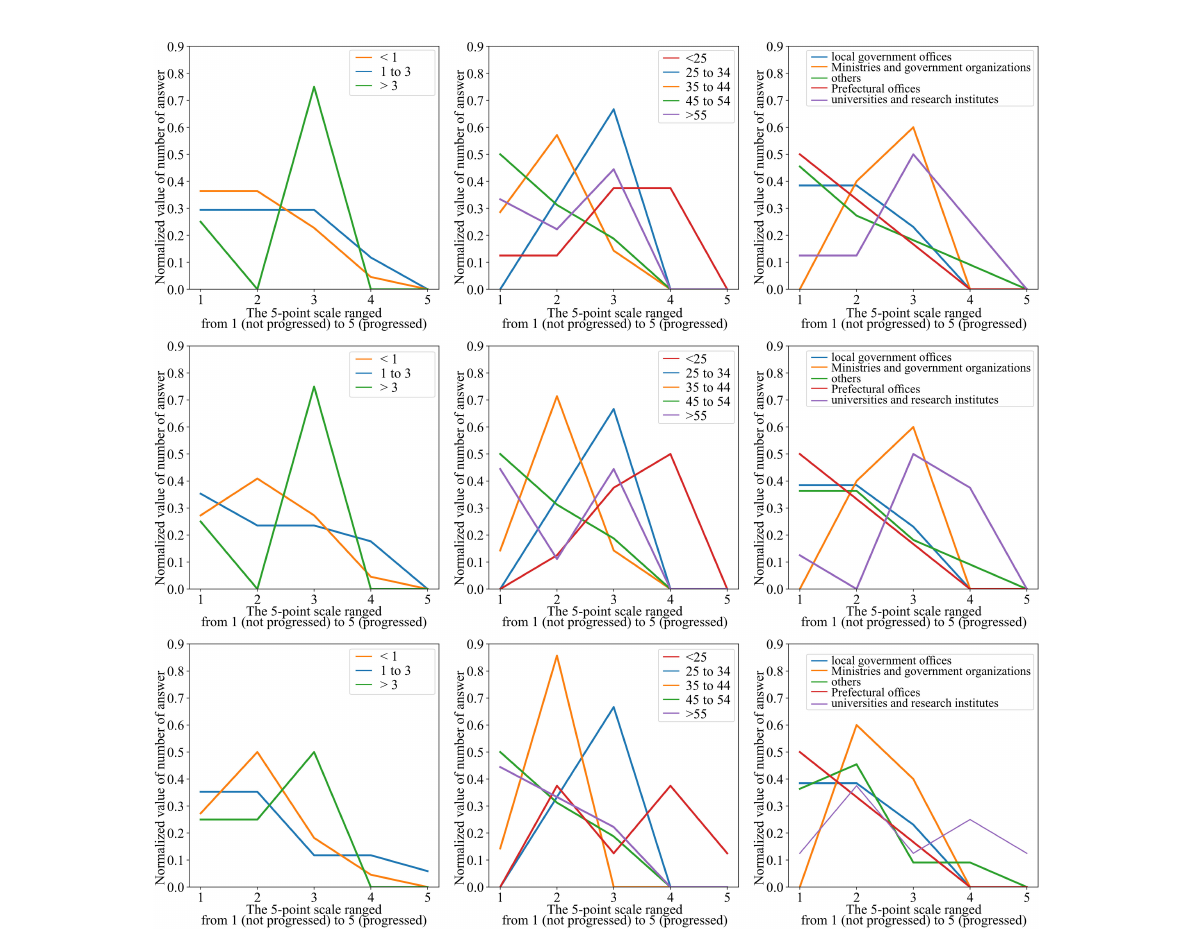
FIGURE 5 Results on the progress offreshwater carbon-related efforts grouped by attributes. As in Figure 2, the results of the three questions are summarized for each of the three attributes. The questions are “ understanding the roles and effects offreshwater carbon ” (left column), “ maintenance of the freshwater carbon ecosystem ” (center column), and “ dissemination and promotion of freshwater carbon ” (right column). The respondent attributes are “ the number of they had known about freshwater carbon ” (top row), “ age ” (center row), and “ organization ” (bottom